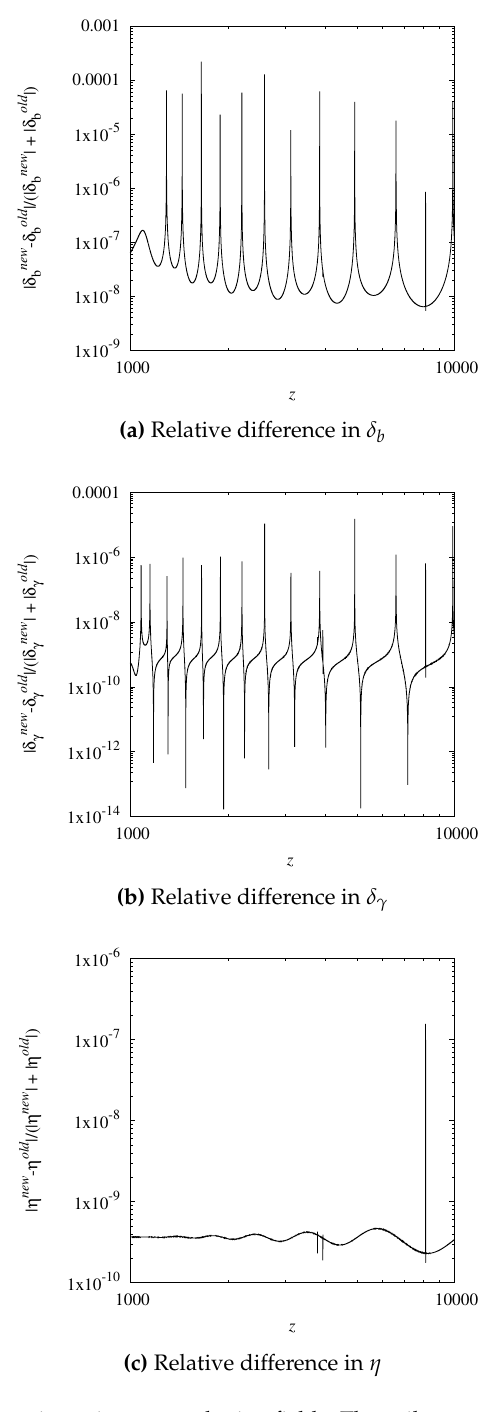
Figure 6. Relative difference in various perturbation fields. The spikes are due to oscillations crossing zero. In order to obtain these figures, we increased the precision of CLASS (simply by setting a lower tolerance for integrating the equations of motion). Furthermore, we had to interpolate the numerical results in order to be able to evaluate and compare the fields at the same